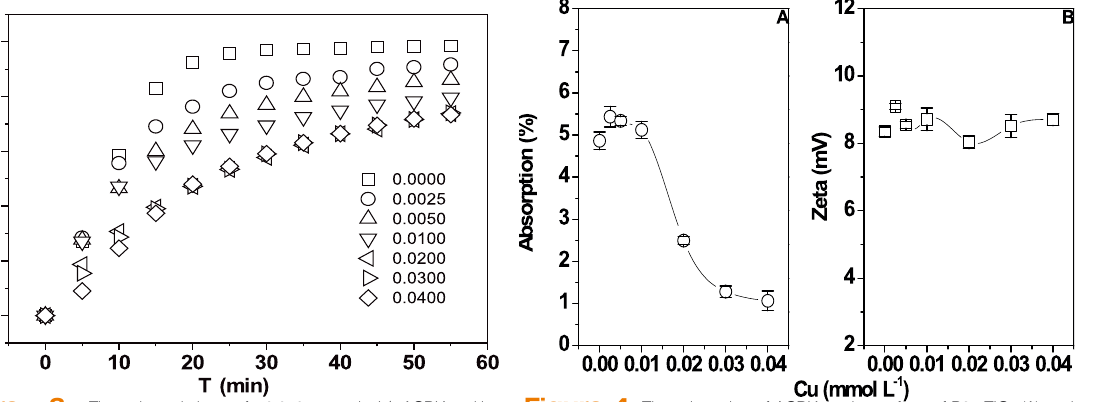
(A) and 2 (B) at different 2